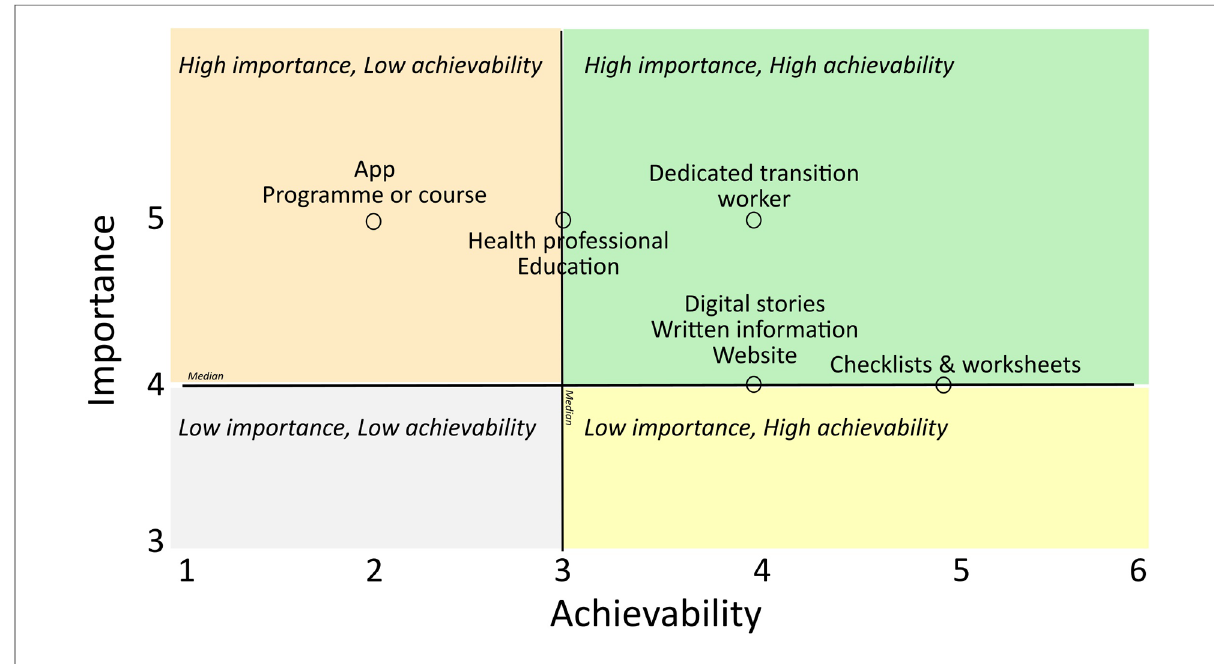
FIGURE 4 2×2 matrix rating achievability and importance of